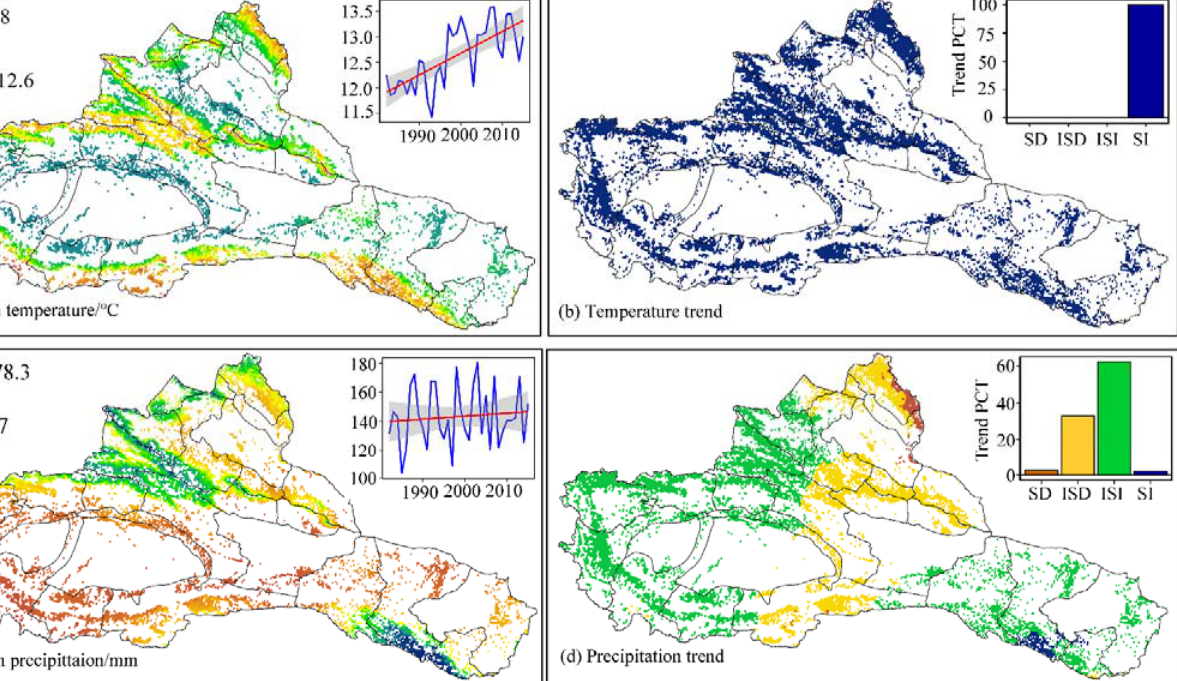
Figure 3. The means ( a , c , e , g ) and trends ( b , d , f , h ) in climate variables and Normalized Difference Vegetation Index (NDVI) during the growing season in the arid region of northwestern China (PCT is the abbreviation of percent; SD, significantly decreasing trend; ISD, non-significant decreasing trend; ISI, non-significant increasing trend; SI, significantly increasing trend). The visualized colors in the left-hand graphs refer to the mean climate and NDVI values, while those in the right-hand graphs refer to the trends in climate and NDVI.